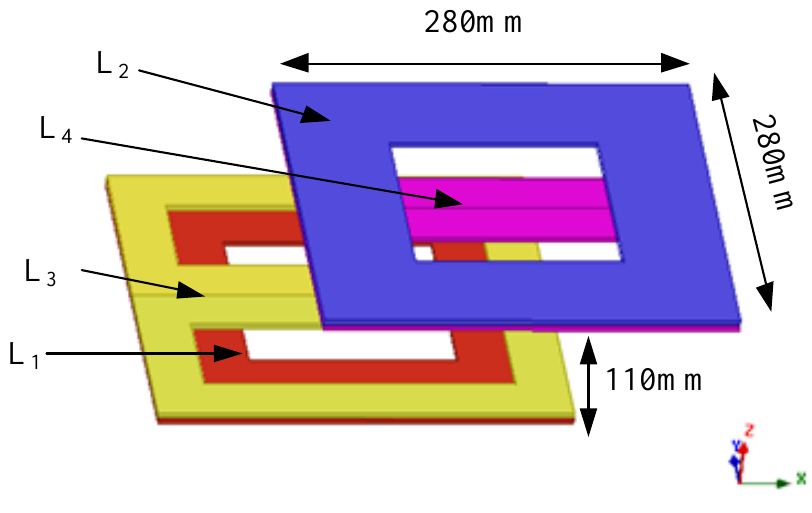
Figure 4. The DDQ magnetic coupler.